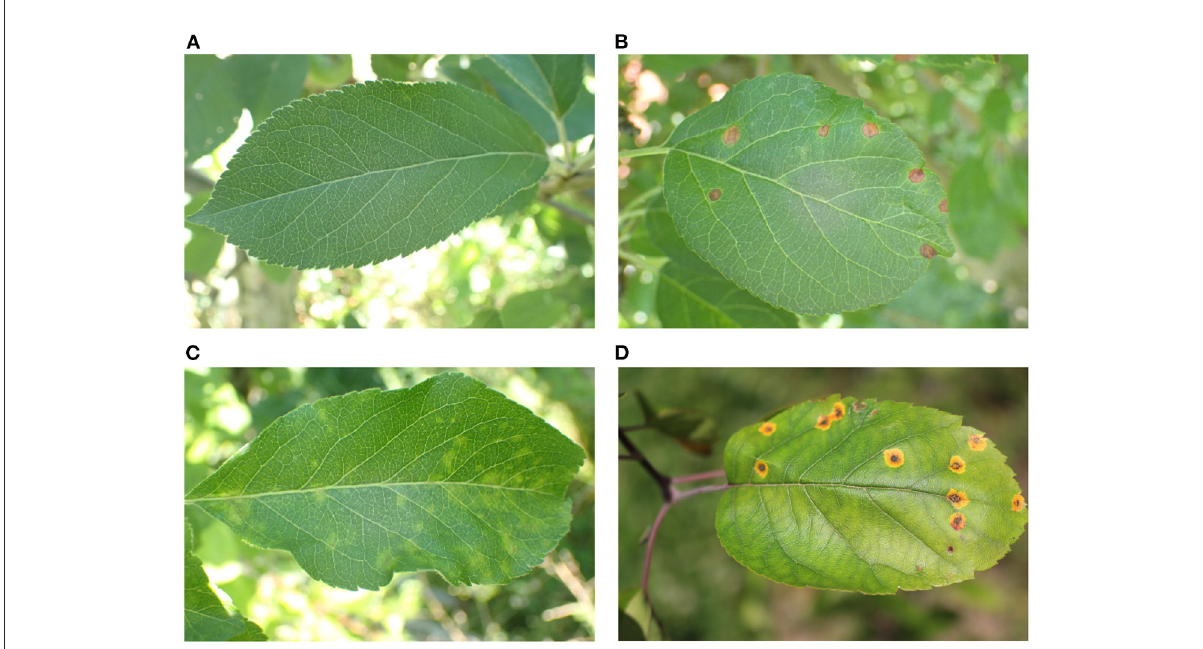
FIGURE8 Representative images of healthy, rust, scab, and black rot apple leaves. (A) Healthy. (B) Rust. On leaves, cedar-apple rust first appears as small, pale yellow spots on the upper surfaces. The spots enlarge and eventually tiny black fruiting bodies become visible. Often several orange-yellow protuberances are produced in each spot on the underside of the leaf. (C) Scab. The scab leaf spots are round, olive-green, and up to 1/2-inch across. Spots are velvet-like with fringed borders and often form along the leaf veins. As they age, leaf spots turn dark brown to black, grow bigger, and join together. (D) Black rot. The fruit rot phase is called black rot (also called frog eye leaf spot) on leaves. At the beginning of frogeye spot disease, tiny purple specks appear on infected leaves. Gradually, they grow larger into a round spot with a light brown-to-gray center surrounded by one or more dark-brown concentric rings with a purple margin, giving it a “frog eye”